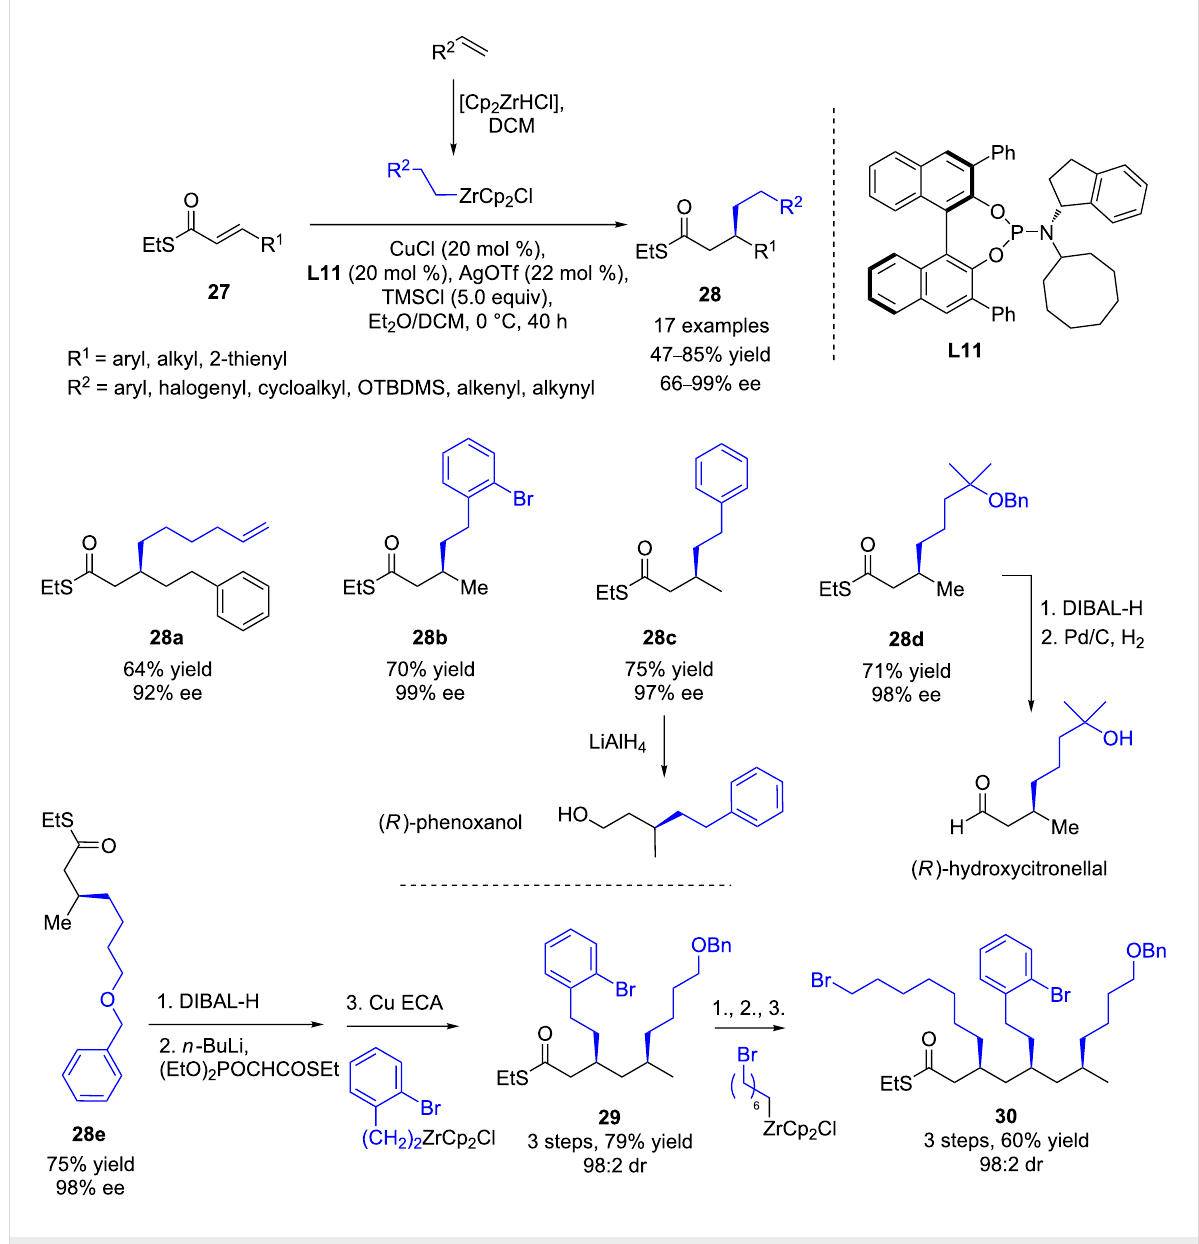
Scheme 12: Cu ECA of alkylzirconium reagents to α , β -unsaturated thioesters.